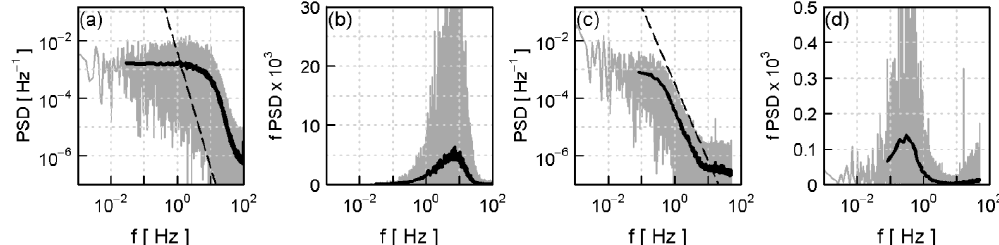
Figure 4. Example power spectral density (PSD) and frequency ( f ) spectra for (a, b) the BLS and (c, d) unfiltered MWS for 14:30– 15:00UTC on 2 July 2011. Smoothed spectra (data divided into 100 bins) are shown in black. The dashed lines represent theoretically predicted slopes of − 12/3 and − 8/3 for the BLS and MWS,